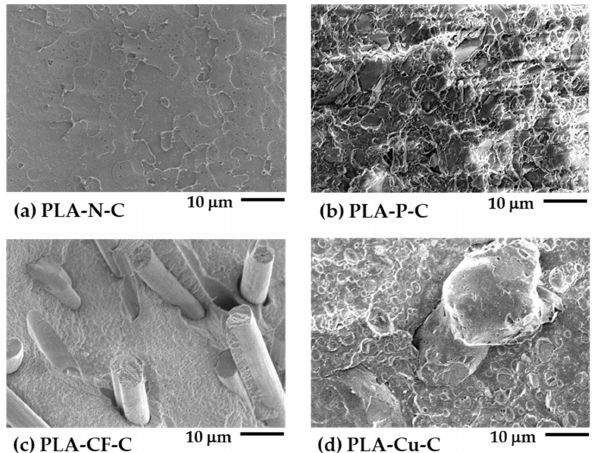
Figure 3. SEM images of cryogenic fractured surfaces of PLA filaments compression molded sheets: ( a ) PLA-N-C; ( b ) PLA-P-C; ( c ) PLA-CF-C; and ( d )